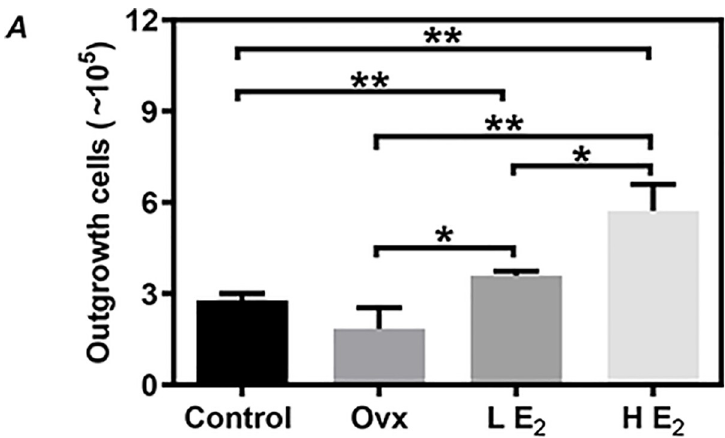
Fig 1. The outgrowth of cardiac stem cells (CSCs) from the atrial tissues of mice. The outgrowth of CSCs was evaluated 2 weeks after the initiation of culture. Control: sham-operated mice, Ovx: ovariectomized mice, LE 2 : ovariectomized mice supplemented with low dose of 17 β -estradiol (0.01 mg/60 days), HE 2 : ovariectomized mice supplemented with high dose of 17 β -estradiol (0.18 mg/60 days). All data are mean ± SD from 3 independent experiments (n = 3 for each group). � P < 0.05, �� P <